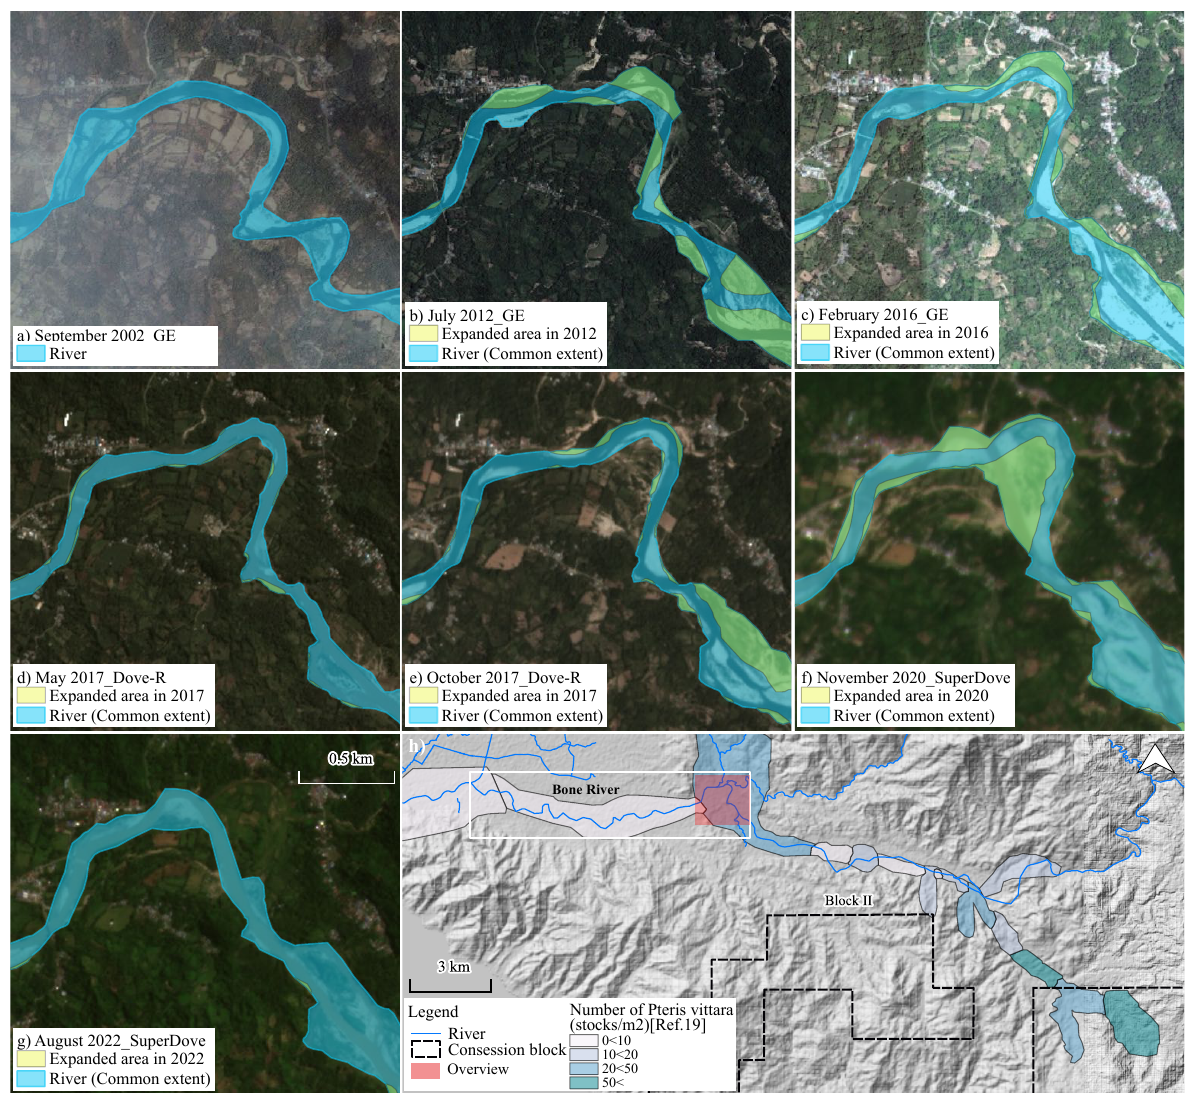
Figure 8. Transformations of east side river extents using PlanetScope series; (a–g) transformations of river extents by highlighting differences (2002–2022); (h) site overview.